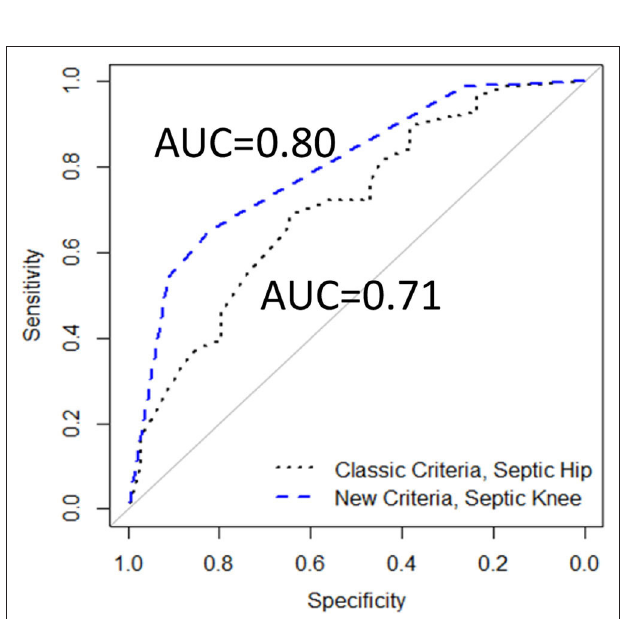
FIGURE 3 | The receiver-operator curves (ROCs) comparing Classic Criteria model to a New Criteria model, including age and CRP (117 patients), AUC, area under the curve.